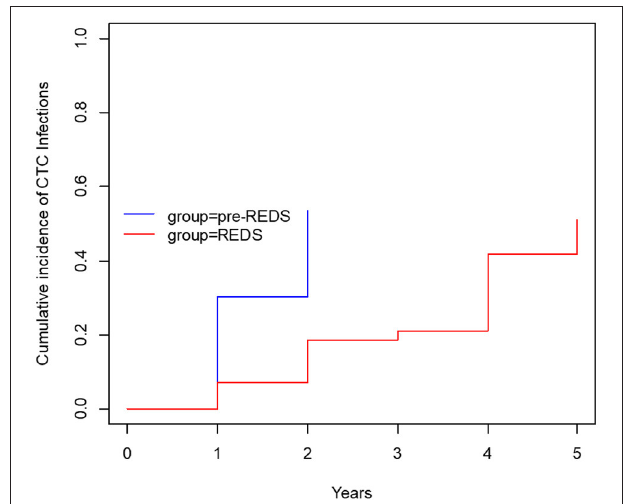
FIGURE 2 | The cumulative incidence of ESI (before and after REDS).